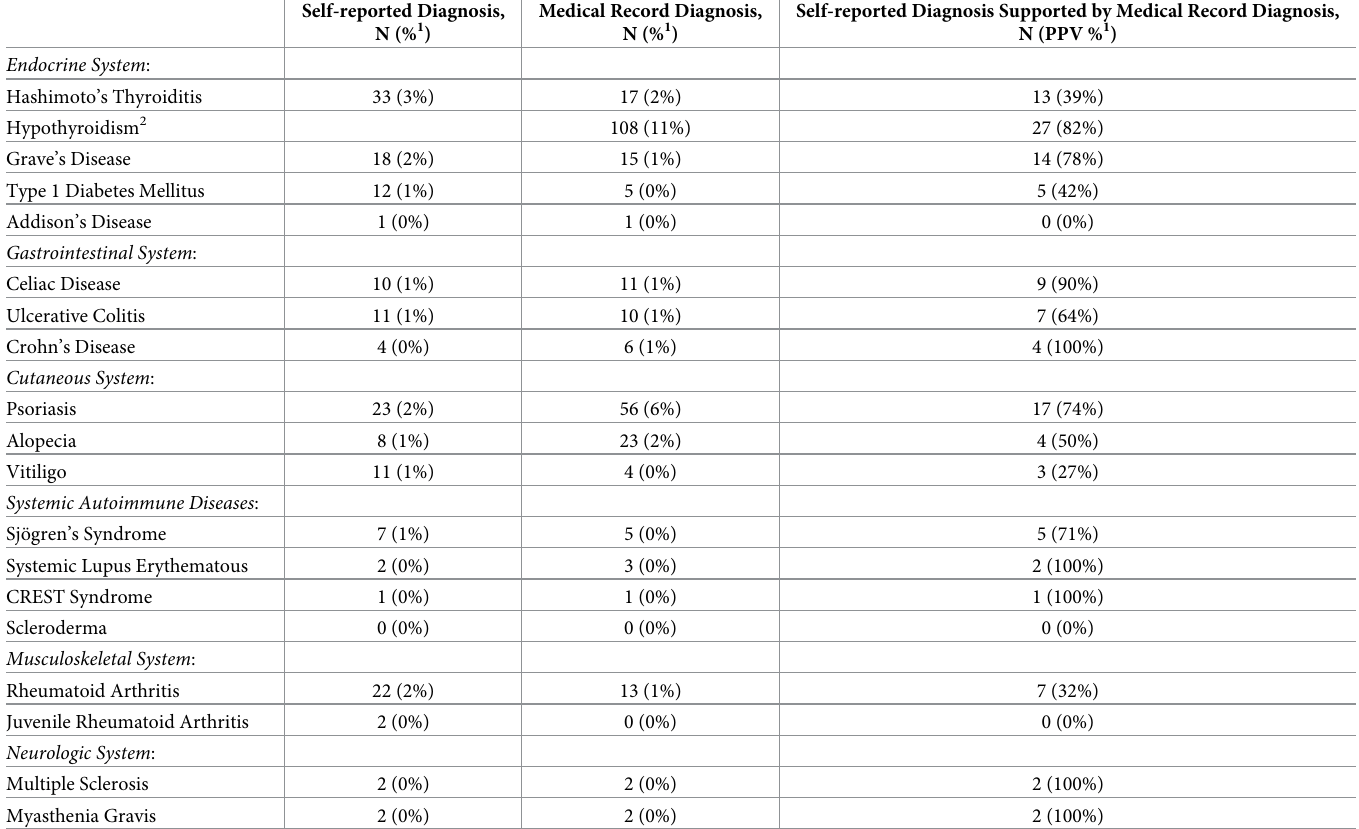
Table 2. Prevalence of autoimmune disease diagnosis according to self-report and medical record review, and overlap of self-report and medical record endorse- ment, by biological